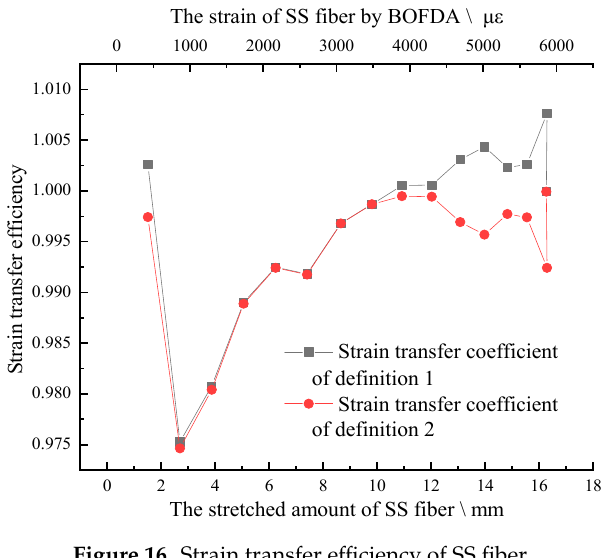
Figure 16. Strain transfer efficiency of SS fiber.